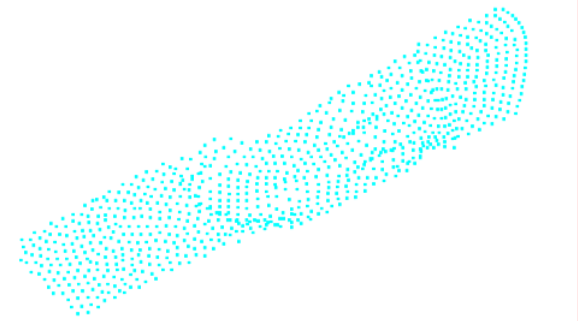
Figure 8: Point cloud after sampling on surfaces